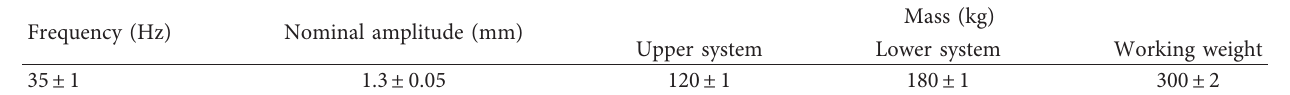
Table 3: Working parameters of vertical vibration testing